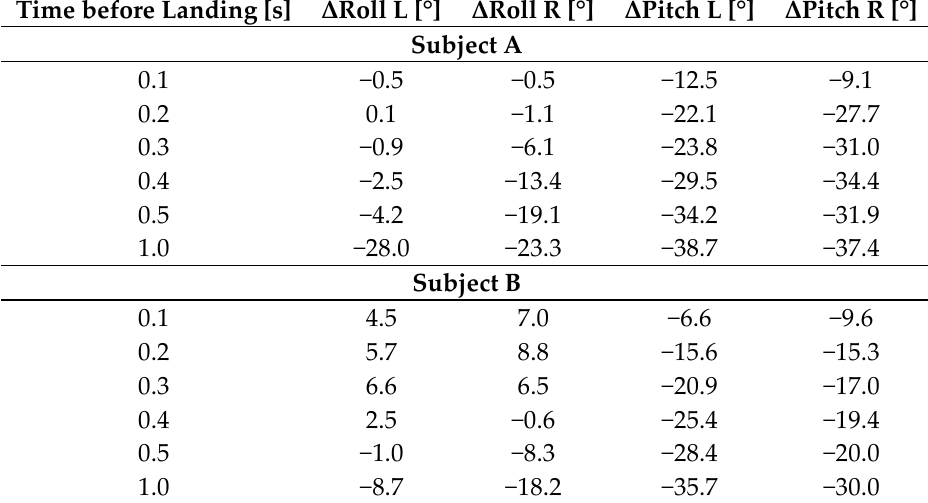
Table 2. Differences (Δ) between the ski angles recorded during landing touchdown (as reference) and the ones recorded at 0.1, 0.2, 0.3, 0.4, 0.5 and 1.0 s before the touchdown. The values belong to two specific sample jumps with a low (subject A) and high (subject B) landing impacts, respectively (L: left; R: right